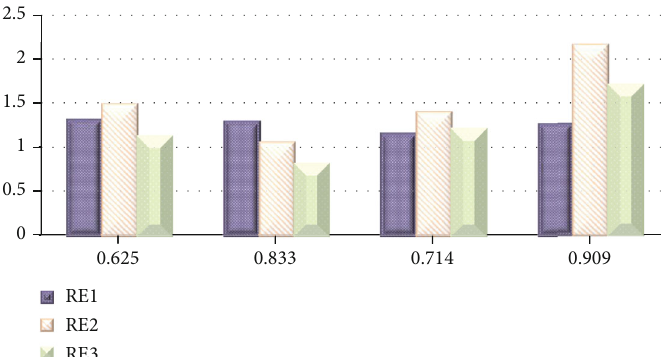
, m = ð 2, 2 Þ 1 2 Þ